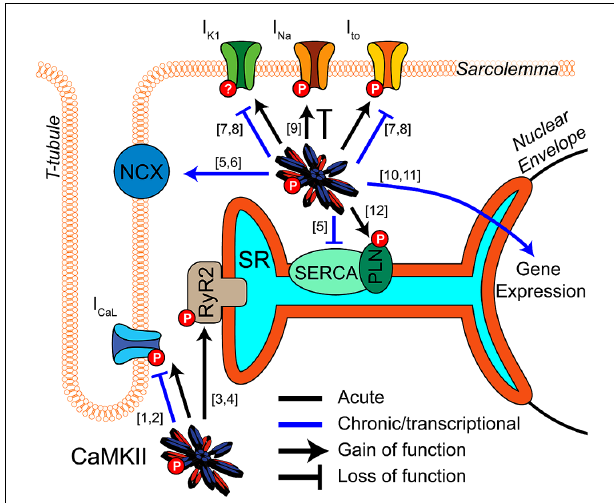
FIGURE 1 | CaMKII regulation of cardiomyocyte electrophysiology and Ca 2+ handling. CaMKII exerts acute (black) and transcriptional (blue) regulation ([10]-Wu etal., 2006; [11]-Backs etal., 2006) of many key proteins in cardiac electrophysiology and calcium handling. Acute phosphorylation of LCCs by CaMKII potentiates I CaL and slows inactivation ([1]-Yuan and Bers, 1994).Transcriptional effects are less established but likely downregulate channel expression ([2]-Ronkainen etal., 2011). Phosphorylation of RyR2 by CaMKII promotes Ca 2 + release from the SR and is implicated in many proarrhythmic contexts ([3]-Witcher etal., 1991; [4]-Wehrens etal., 2004). Available data suggest CaMKII transcriptional regulation promotes Ca 2 + extrusion from the cell by increasing NCX expression and decreasing SERCA ([6]-Mani etal., 2010; [5]-Lu etal., 2011). I to and I K1 are enhanced by acute CaMKII phosphorylation ([7]-Li etal., 2006), and transcriptional downregulation of these currents is a well-established effect of long term CaMKII activity.This reduces repolarization reserve and may destabilize resting membrane potential ([8]-Wagner etal., 2009). Acute regulatory effects of CaMKII on Na V 1.5 enhance inactivation, decrease availability and potentiate I NaL , but again any transcriptional regulation is unclear ([9]-Wagner etal., 2006). Acute phosphorylation of PLN disinhibits SERCA and enhances SR Ca 2 + reuptake ([12]-Karczewski etal., 1997).